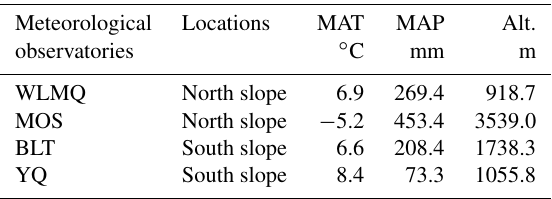
Table 1. Climate data from the meteorological observatories in the research